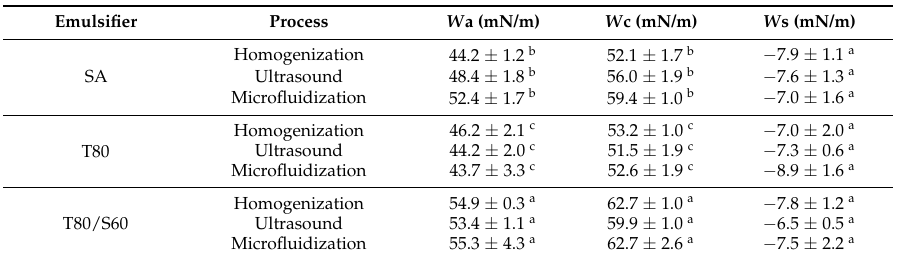
Adhesive forces ( W a), cohesive forces ( W c) and wettability coefficient ( W s) of BW–starch